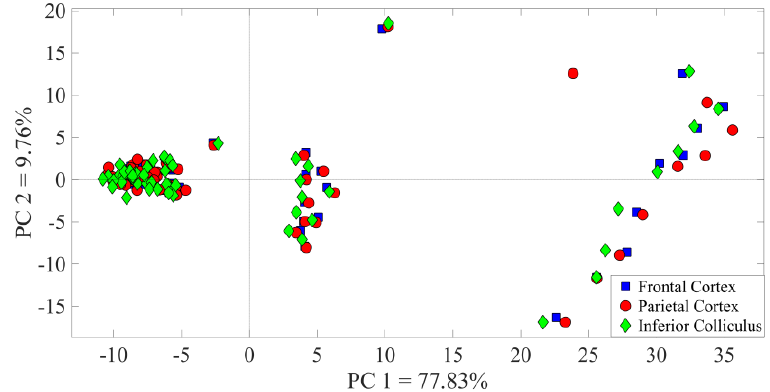
Figure 11. PCA applied in the frontal and parietal cortices and the inferior colliculus (ECoG traces). No significant differences can be seen in the score plot for the three neural areas. The spectral analysis highlights the neuronal rhythms occurring at specific frequencies. Changes in power spectrum density indicated either the activation or deactivation of a specific region.